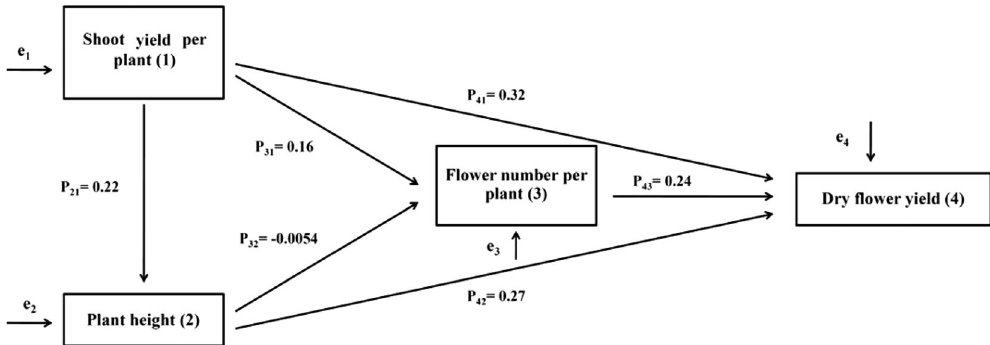
Figure 2. Path coefficients diagram showing the causality path of dry flower yield forming and growth characteristics of Echium amoenum as a result of application of organic and chemical fertilizers and different plant densities (e represents non-measurable errors).